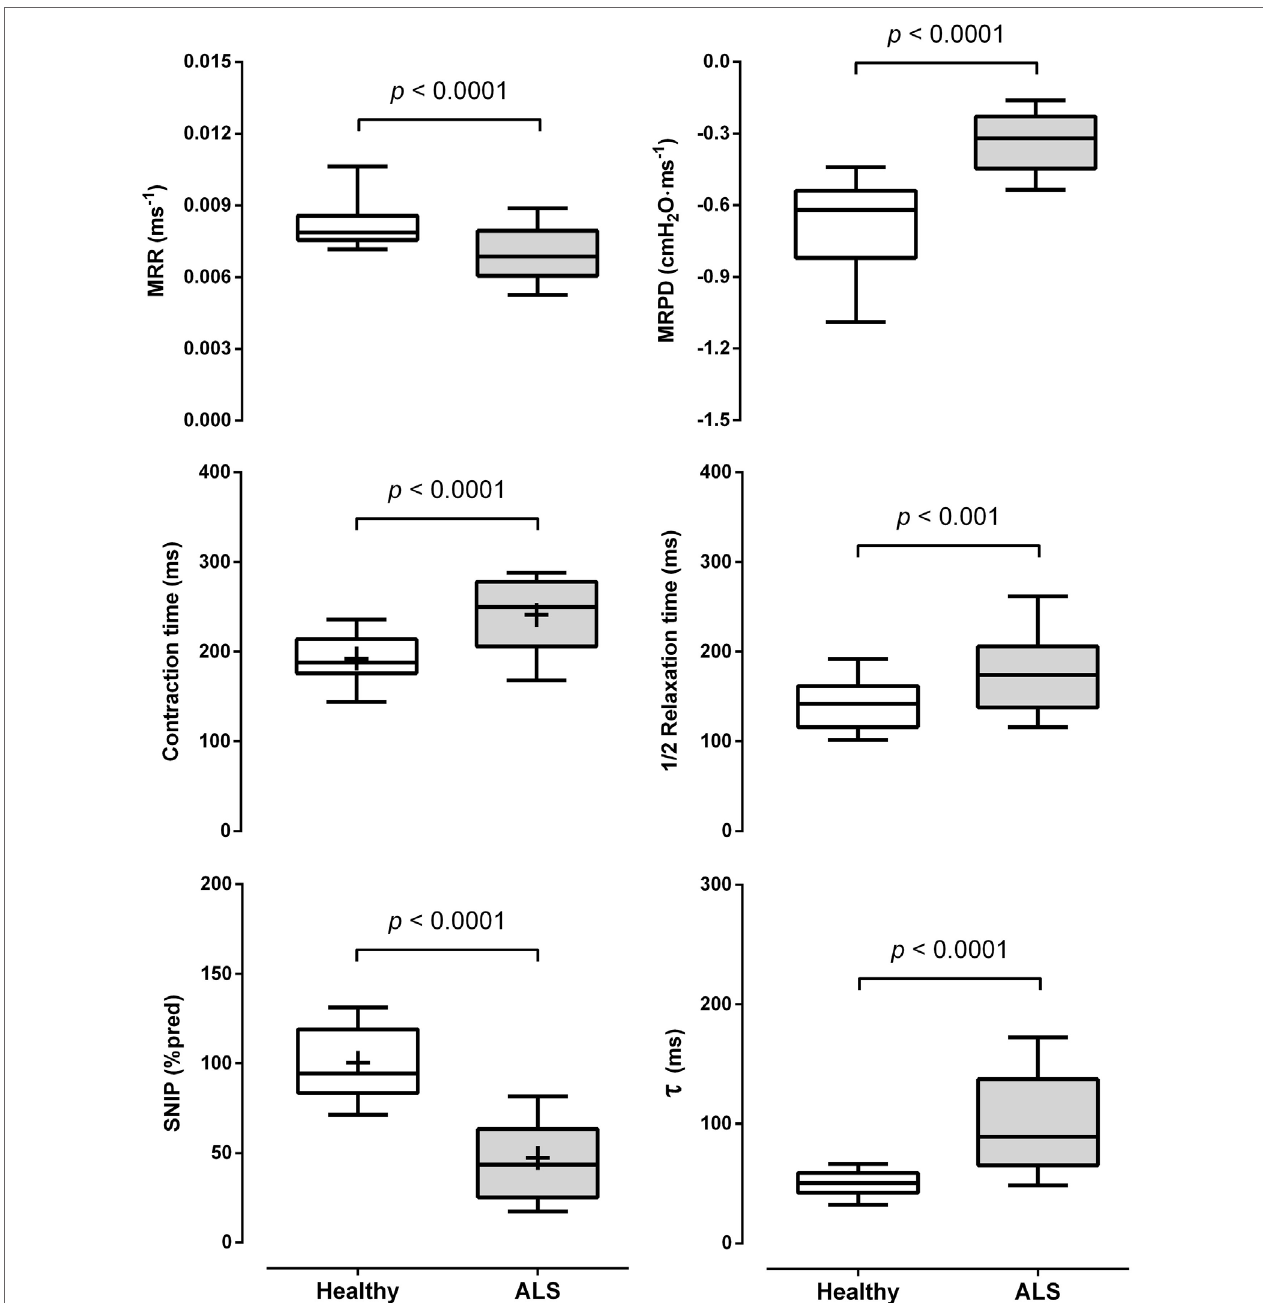
FigUre 2 | Data are shown as median [25–75th percentile]. Comparisons between the parameters obtained from the sniff nasal inspiratory pressure (SNIP) curve [maximum relaxation rate (MRR), maximum rate of pressure development (MRPD), contraction time, half-relaxation time (1/2RT), and tau ( τ )] and percentage of predicted of the SNIP test (SNIP %pred ) between amyotrophic lateral sclerosis (ALS) and healthy subjects. cmH 2 O: centimeters of water; + , mean for parametric